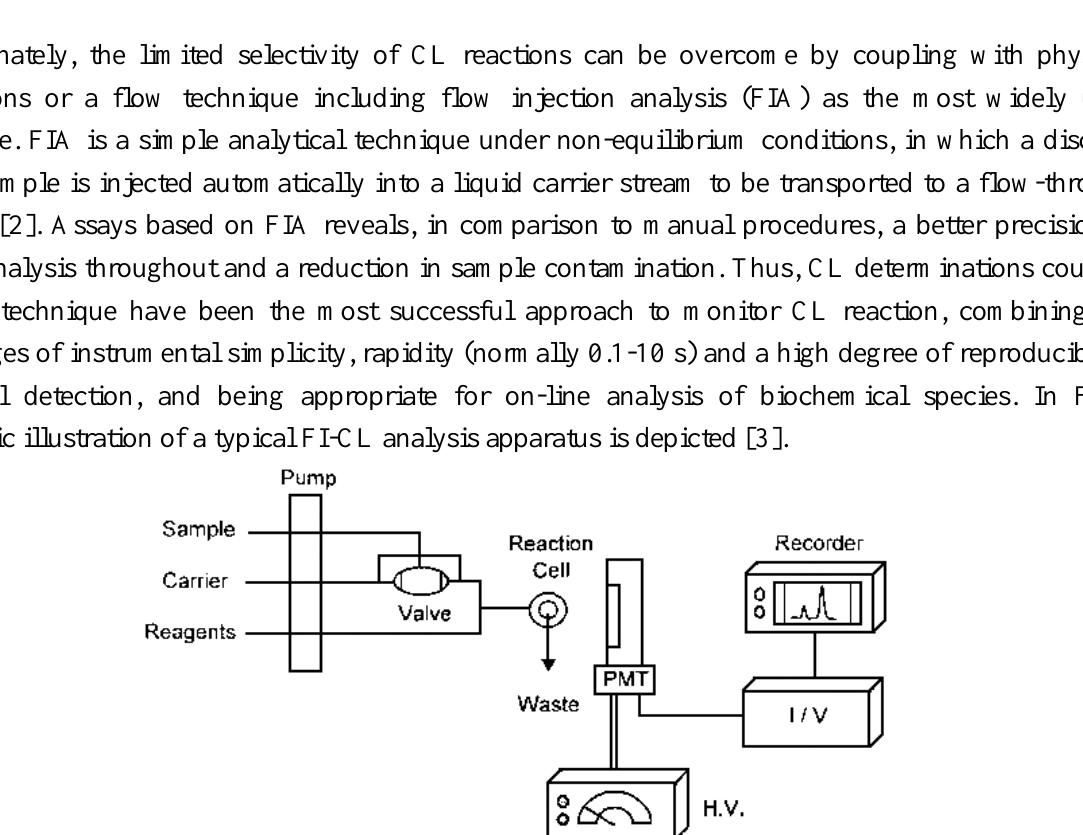
Figture 1. The main mechanisms leading to a chemiluminescent reaction: A, analyte; B, oxidant; C, D, product; F, fluorophore; *, the excited state; h ν , luminescence.